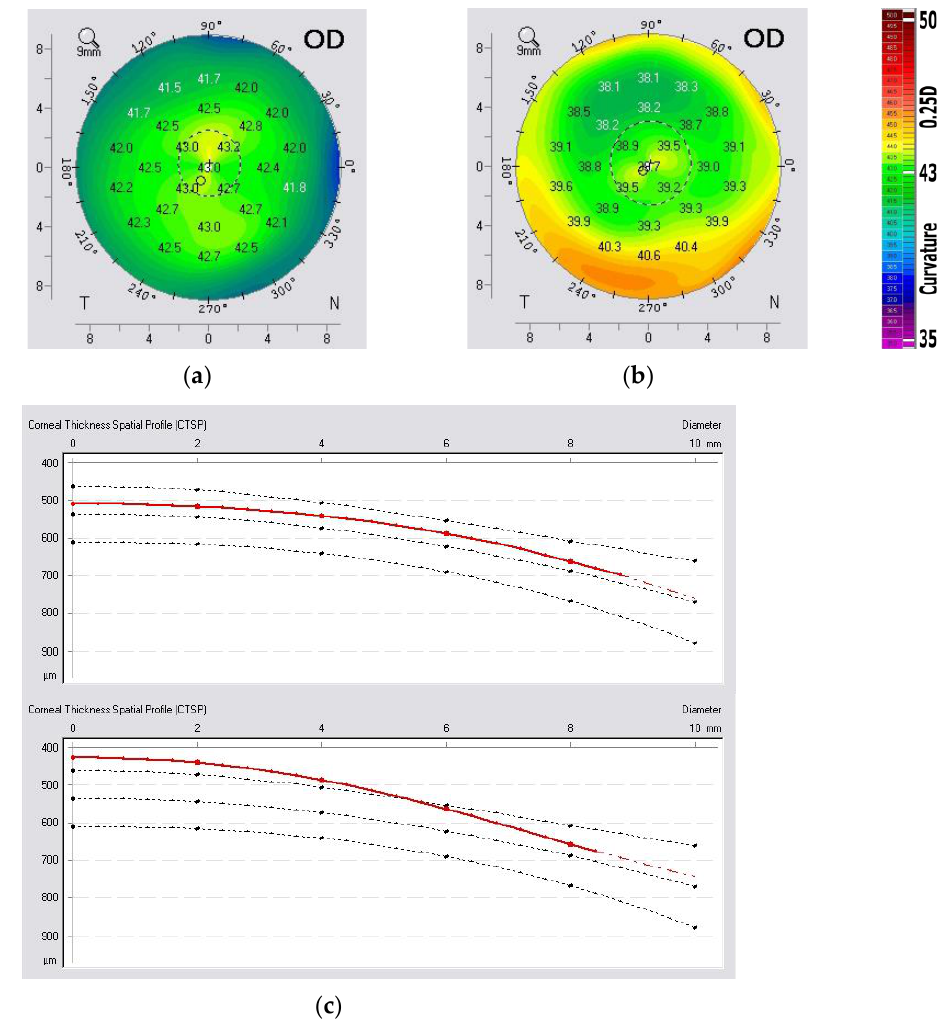
Figure 5. Reconstructed WF on the anterior surface cornea before ( a ) and after ( b ) laser vision correction; corresponding spatial profiles of corneal thickness ( c ): red–current, dotted line–ideal.